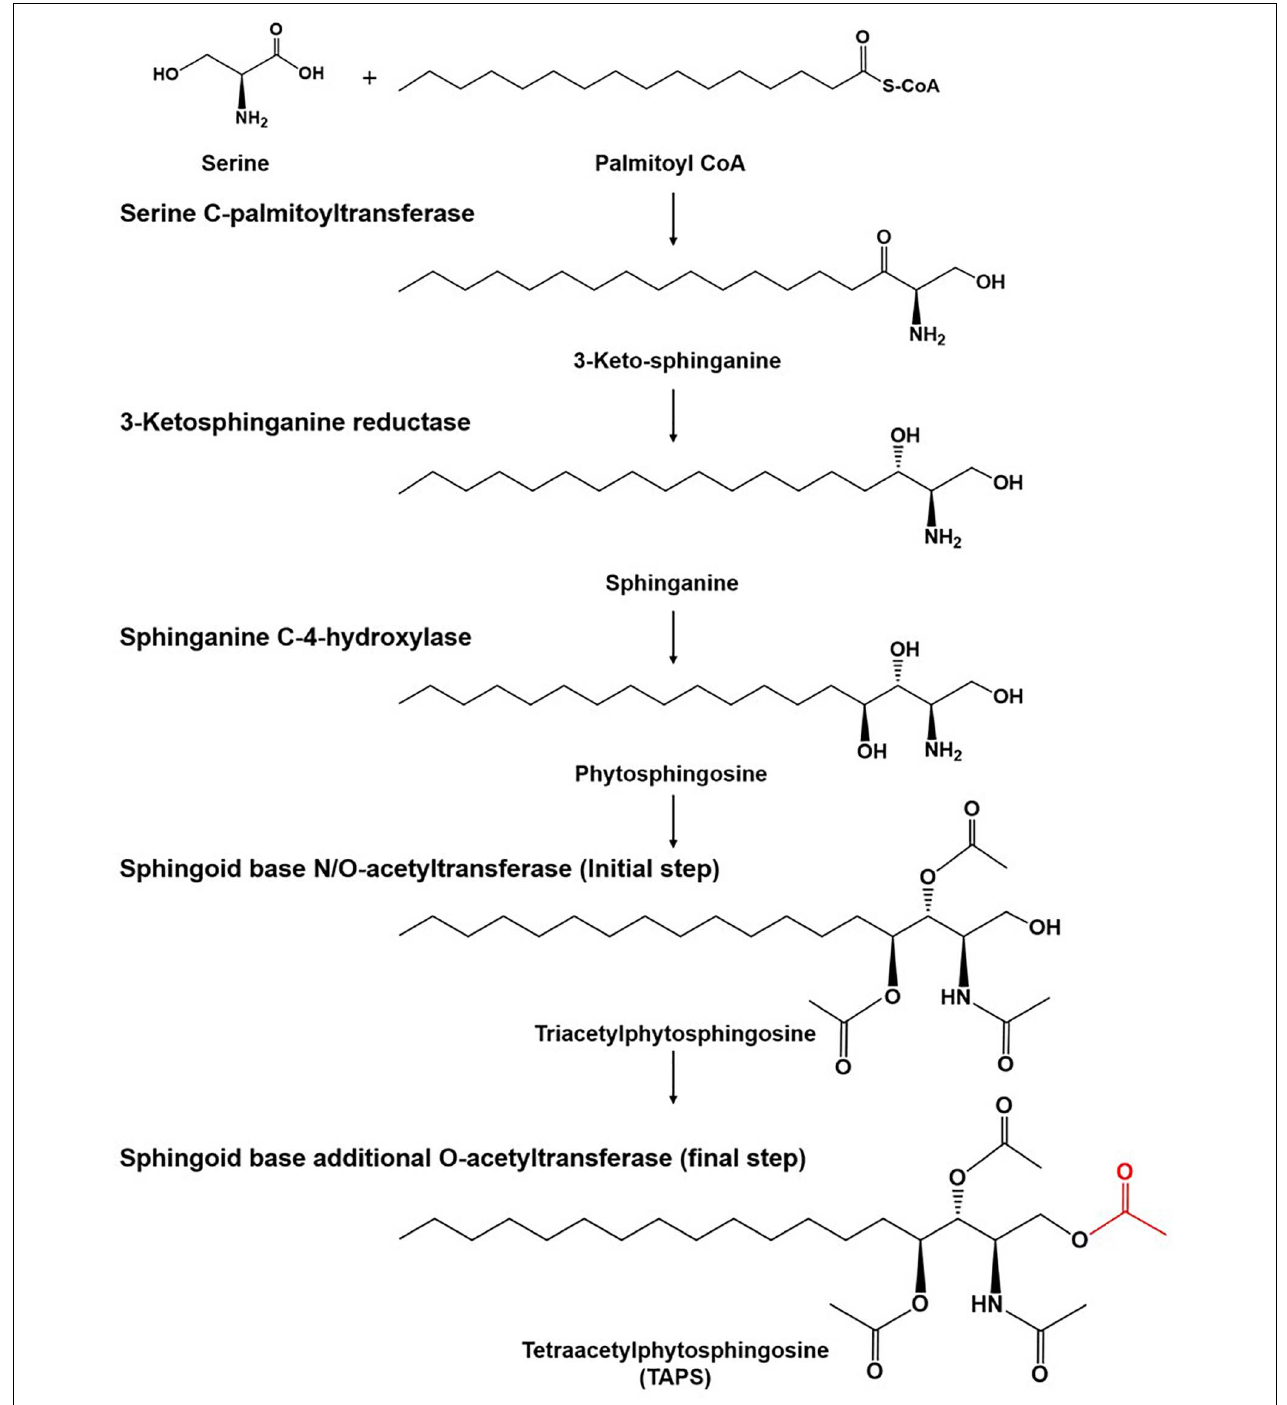
FIGURE 1 | The tetraacetlyphytosphingosine (TAPS) biosynthetic pathway in W. ciferrii. The serine-palmitoyltransferase (SPT) complex composed of Lcb1, Lcb2, and Tsc3 catalyzes the first condensation reaction, between serine and palmitoyl-CoA, to produce 3-keto-sphinganine. The next step is mediated by 3-keto-sphinganine reductase (Tsc10) and yields sphinganine. Sphinganine C-4-hydroxylase (Syr2) adds a hydroxyl group to sphinganine to produce phytosphingosine. Sphingoid base N-/O-position acetyltransferase (Sli1p) and O-position acetyltransferase (Atf2p) are sequentially involved in acetylation reactions and produce TAPS (the final acetylated moiety is highlighted in red) as a final product. Three compounds (triacetyl sphinganine, sphinganine-1-P, and phytosphingosine-1-P) are destined for other metabolic pathways.